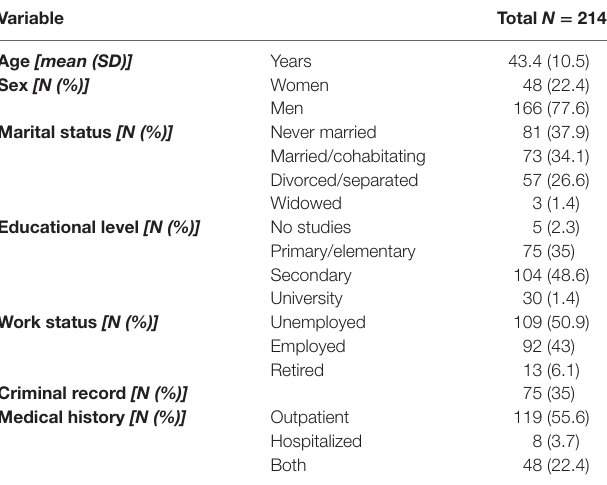
Table 1 | Sociodemographic